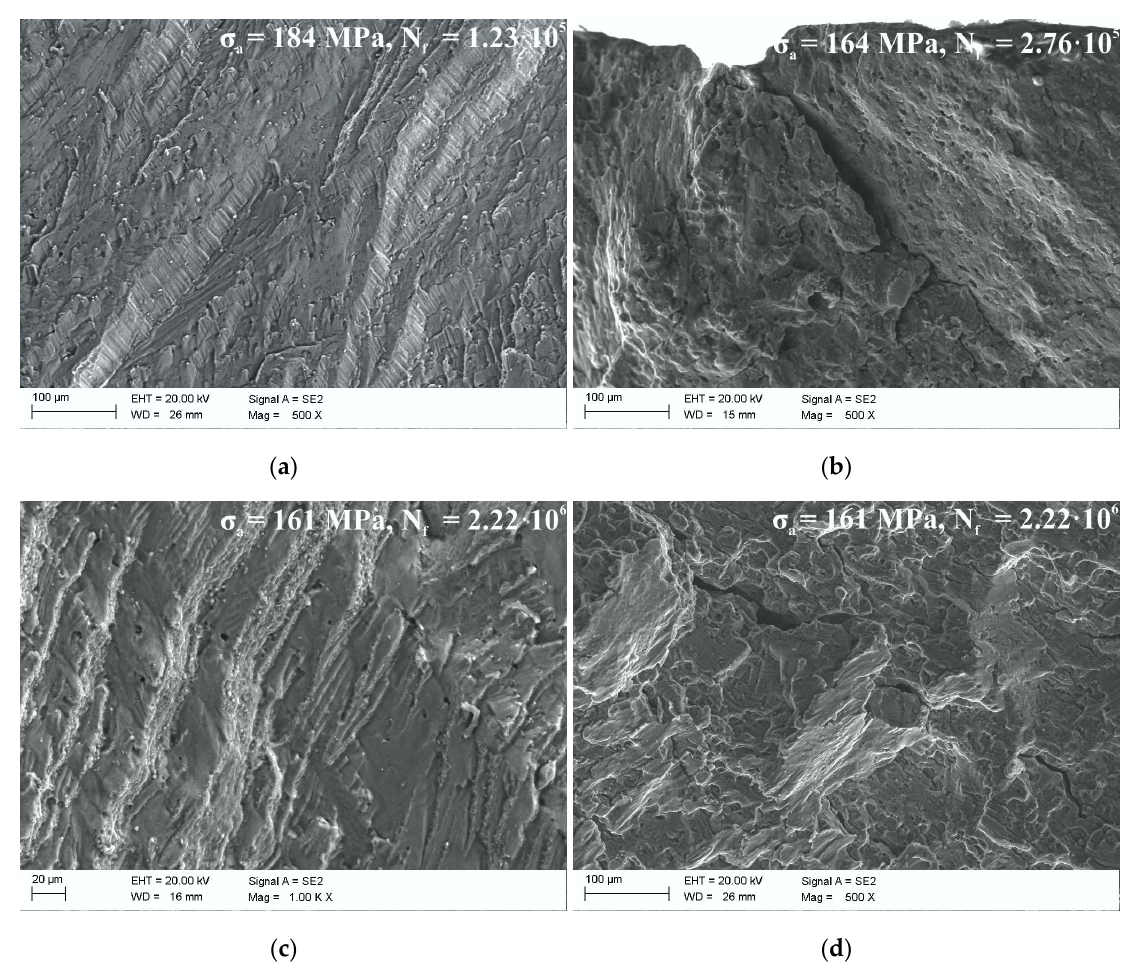
Figure 10. Fractures of fatigue test samples (oscillatory bending) of AlZn6Mg0.8Zr alloy, subjected to LTMP with 10% degree of deformation: ( a ) traces of plastic deformation of the jogs surfaces of fatigue crack planes; ( b ) origins of fatigue fracture in the surface area; ( c ) traces of plastic deformation on the jogs surfaces of cleavage planes; ( d ) local material tears and cracks on the fatigue fracture surface.